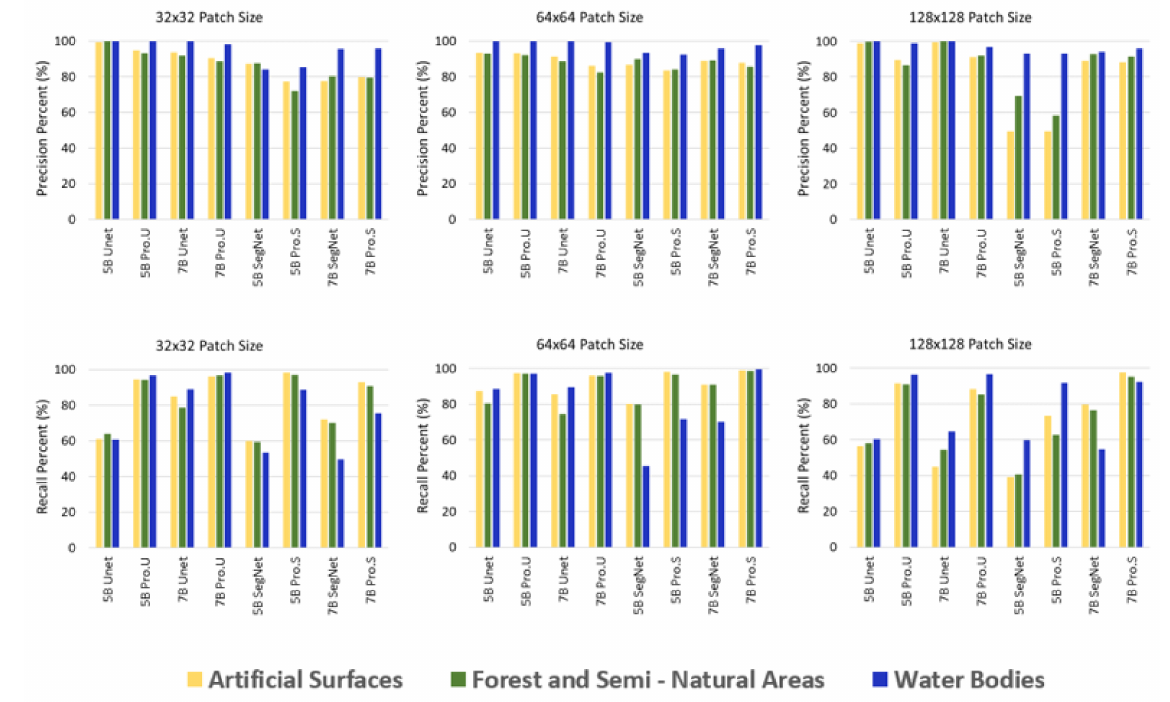
Figure 16. Precision and recall values of different patch sizes for Istanbul test area. Pro.U is proposed approach as CNN (U-Net)–MRS and Pro.S. is proposed approach as CNN (SegNet)–MRS.